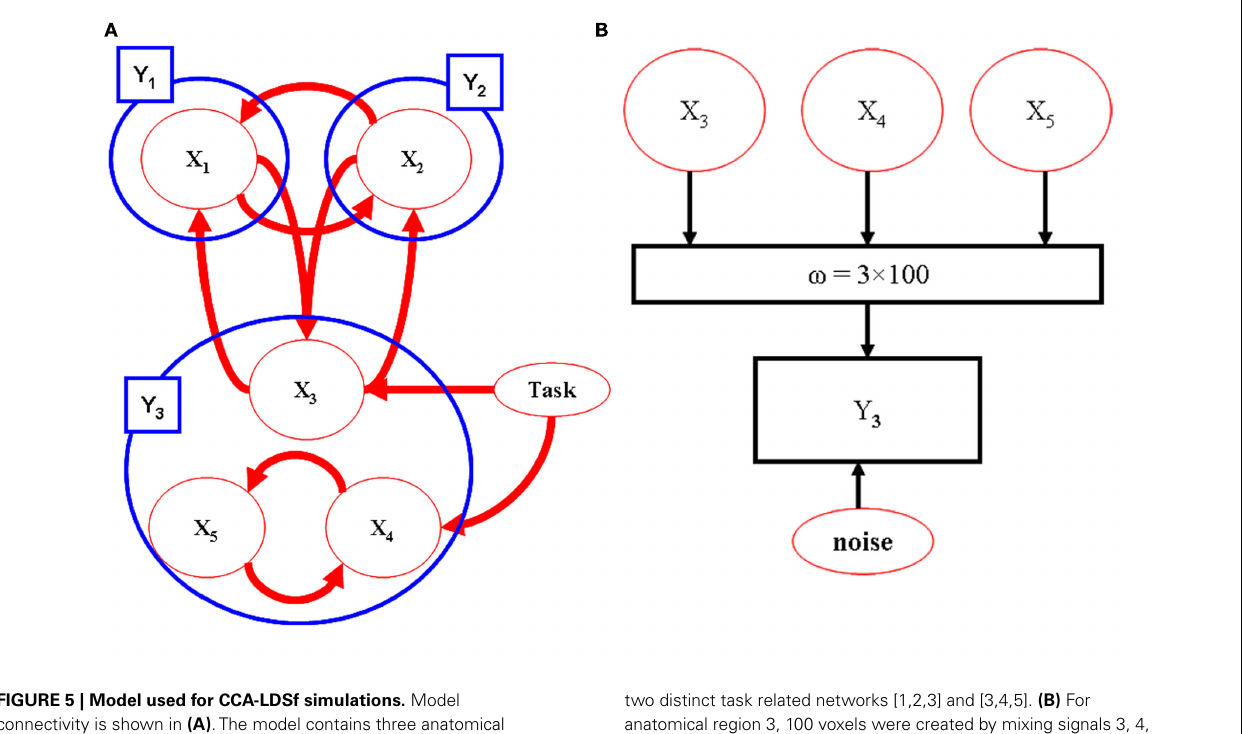
FIGURE 5 | Model used for CCA-LDSf simulations. Model connectivity is shown in (A) .The model contains three anatomical regions (blue circles). Regions 1 and 2 contain a single signal each while region three contains three signals (red circles).The signals form